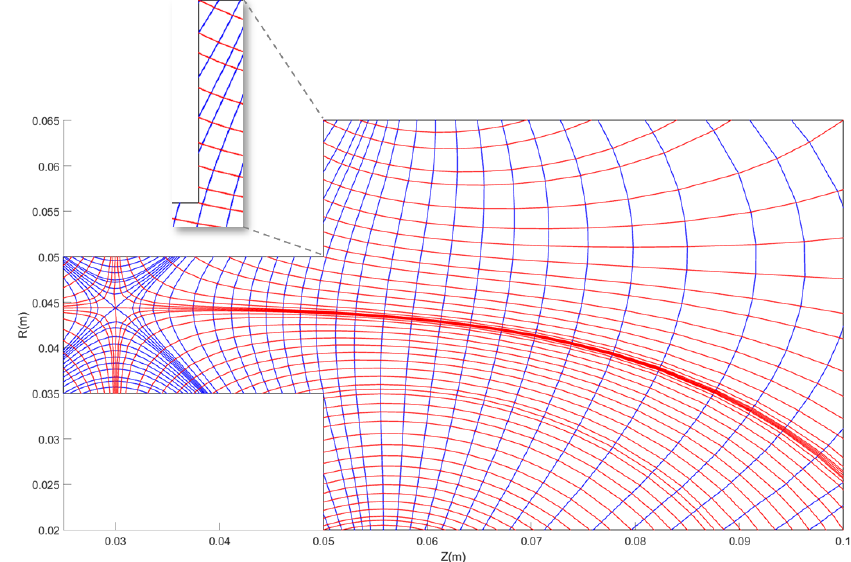
Figure 8. Meshing example illustrating the Expanded Exponential Stretching method with posterior manual correction in a magnetic field topology with a singular point. A zoom close to the domain’s boundary is included in the top part of the